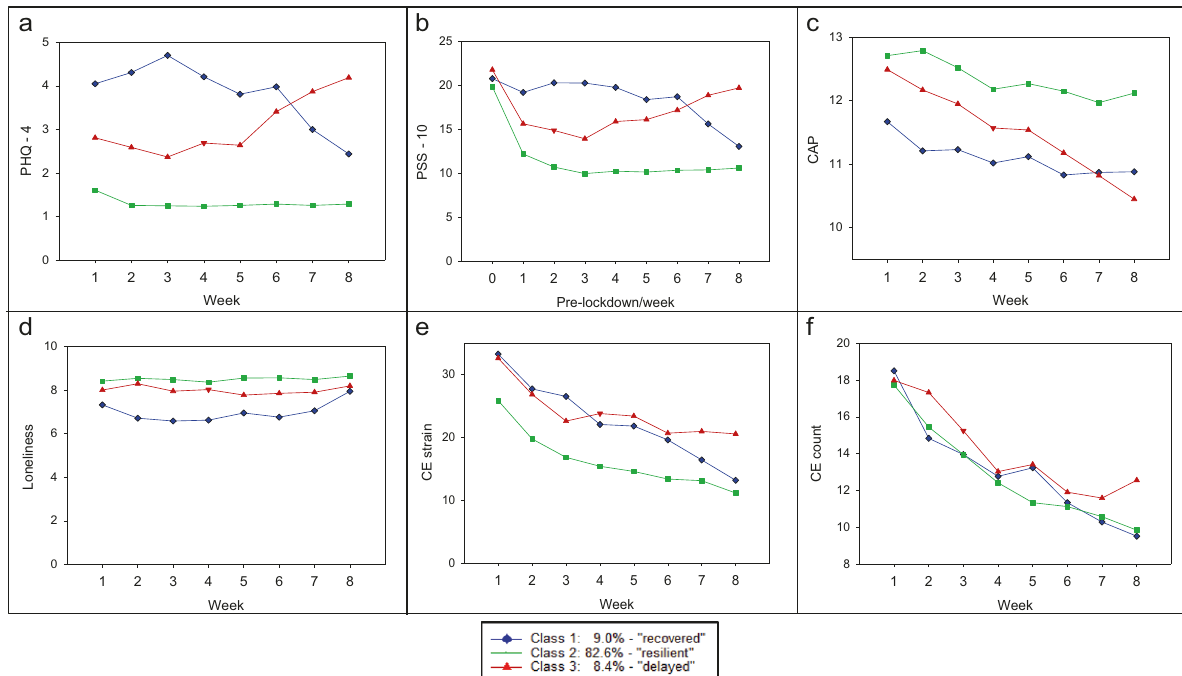
Fig. 5 Comparison of three latent classes (see Fig. 4) over the 8-week time frame. a PHQ-4 means, b PSS-10 means, c positive appraisal sum scores (CAP), d mean loneliness scores (low values on the Loneliness Scale indicate strong feelings of loneliness), e mean of COVID-19-related events strain, f mean frequency of COVID-19-related events. PHQ-4, mean of signs of depression and anxiety; PSS-10, perceived stress; Class 1 blue, “ recovered ” ; Class 2 green, “ resilient ” ; Class 3 red, “ delayed dysfunction ”